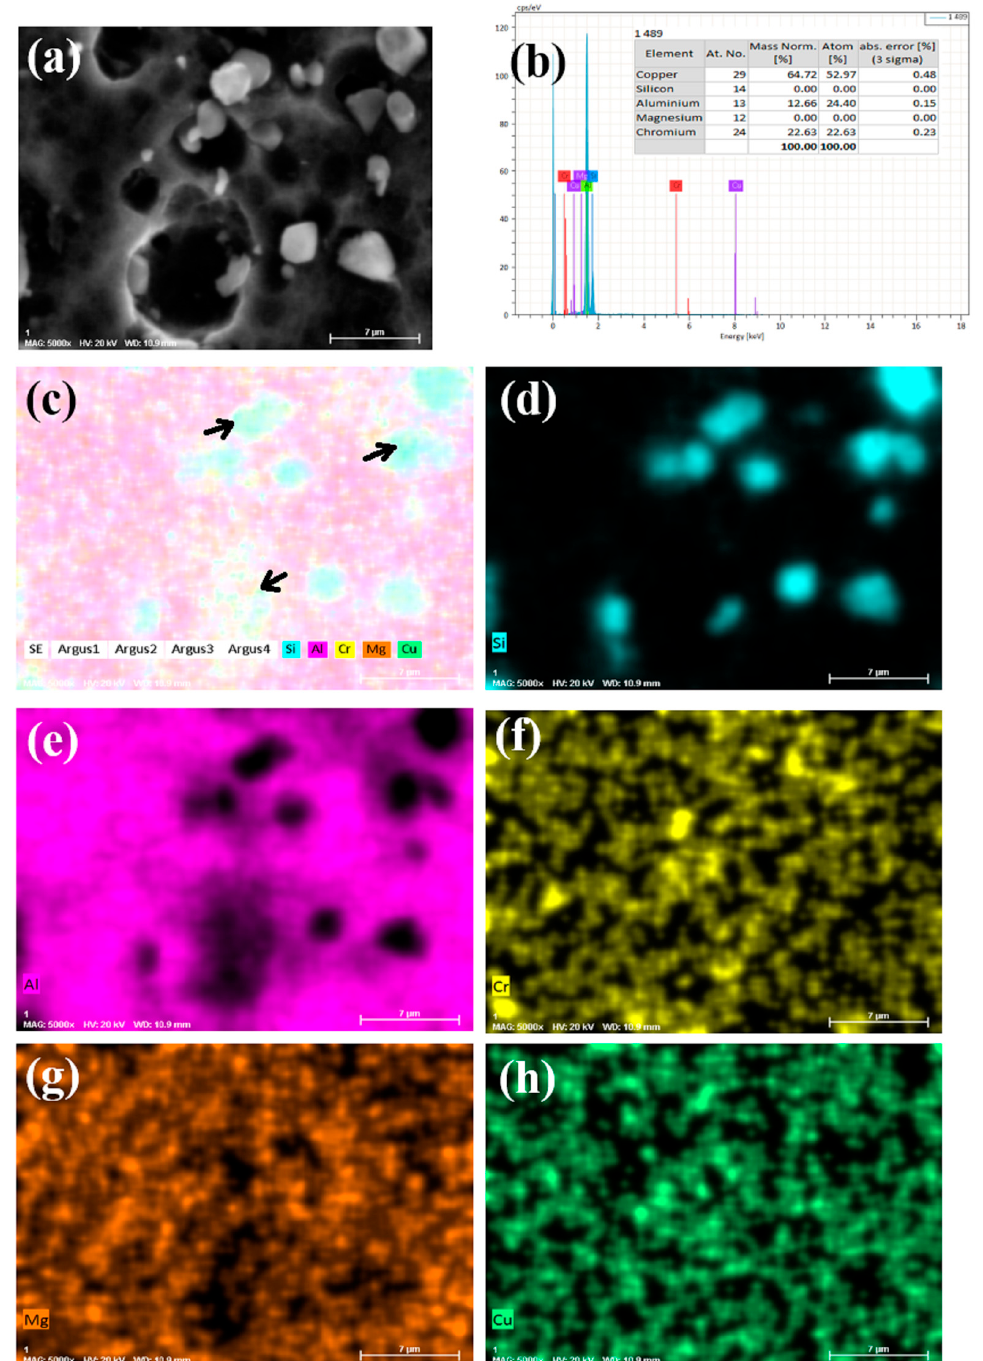
Figure 9. Microstructure and EDS mapping of Al-7%Si-0.3%Mg-0.3%Cr-1.5%Cu alloy after 30-days immersion, ( a ) 5000×, ( b ) EDS results, and corresponding EDS maps of elements ( c ) all elements, ( d ) Si, ( e ) Al, ( f ) Cr, ( g ) Mg, ( h )Cu.